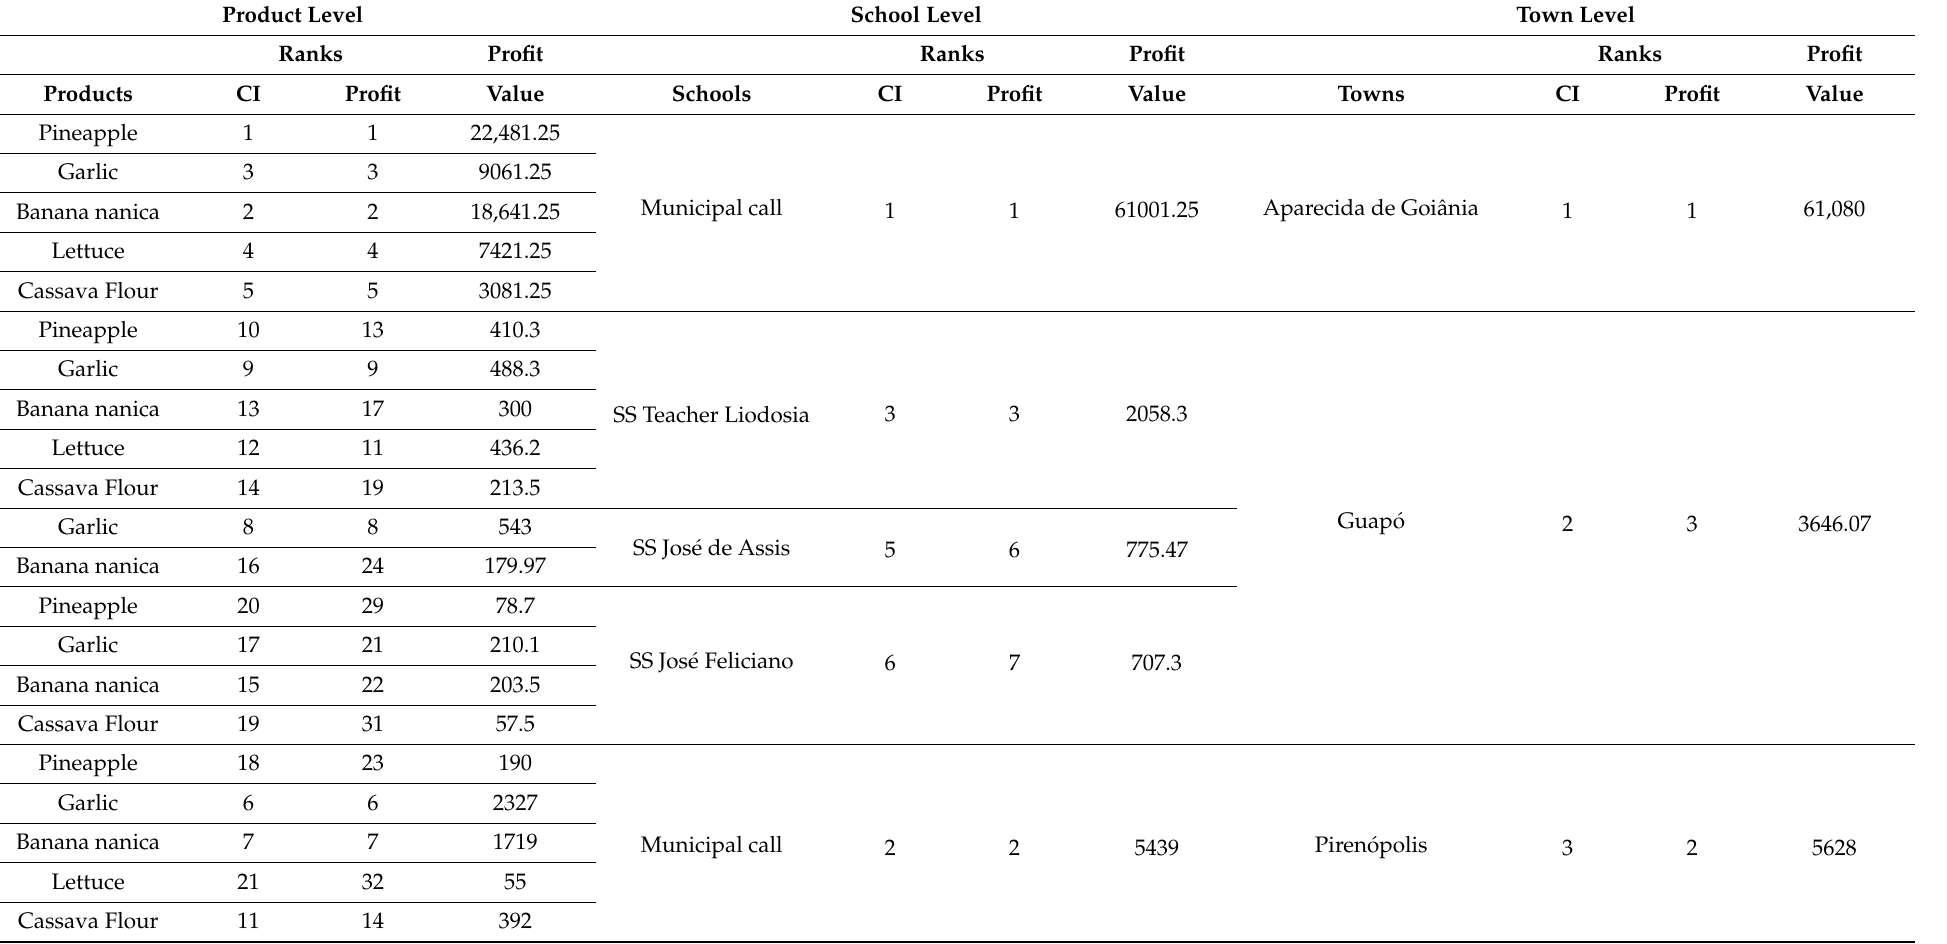
Table 3. Comparison between the rank based on efficiency—Composite Index ( CI )—and the rank based on the profits. Product